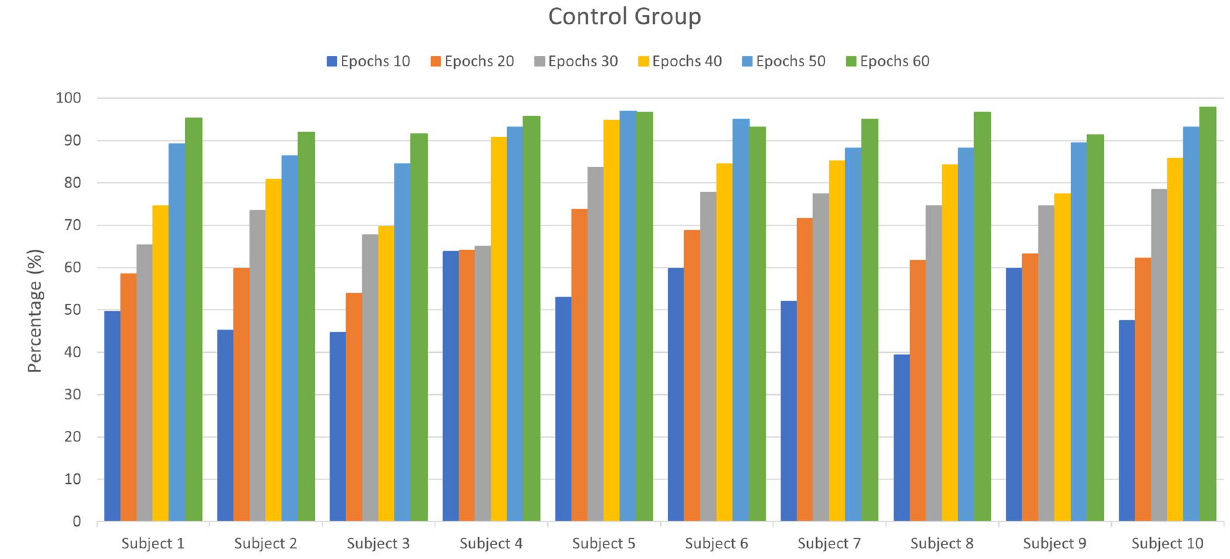
Figure 5. The accuracies obtained by the learned CNN model on control group subjects at epochs from 10 up to 60.